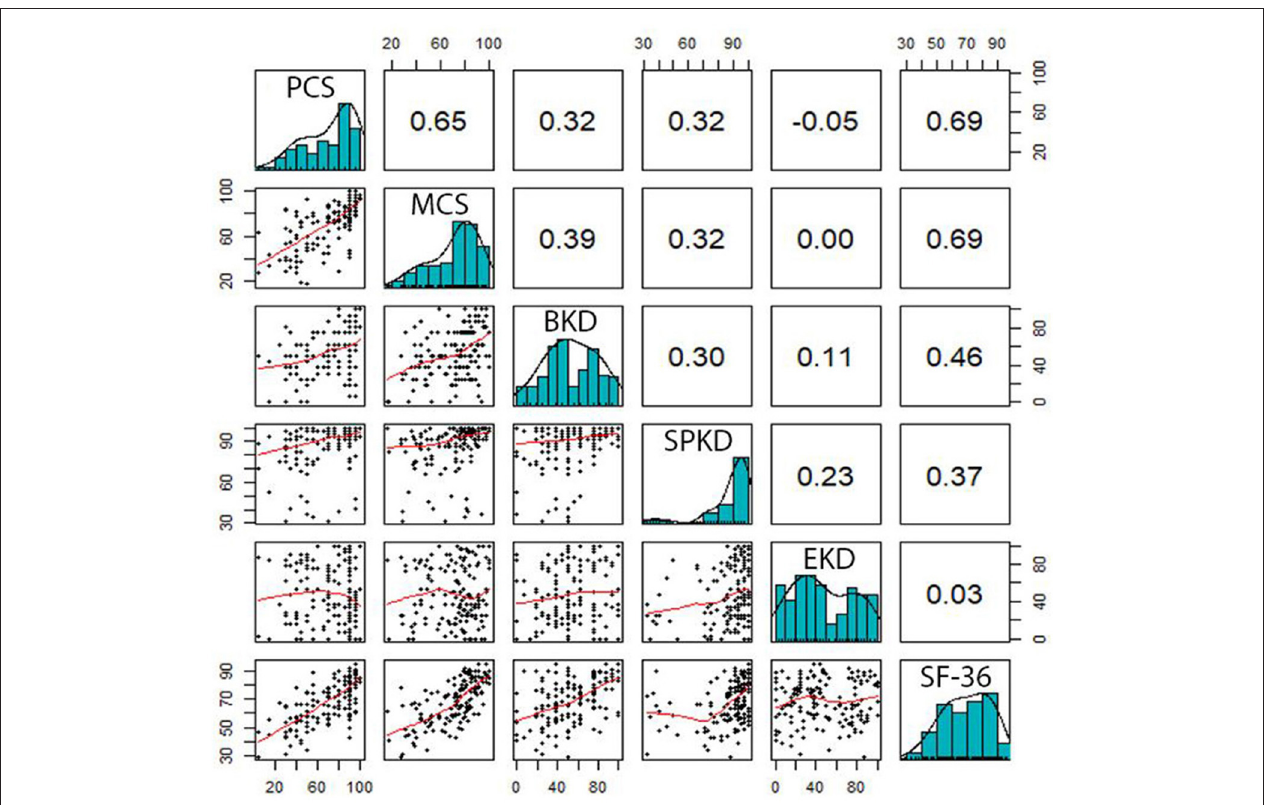
FIGURE 2 | Correlation between the domains measured by the SF-36 and KDQOL-36. PCS, Physical Component Summary; MCS, Mental Component Summary; BKD, Burden of Kidney Disease; SPKD, Symptoms and Problems of Kidney Disease; EKD, Effects of Kidney Disease.